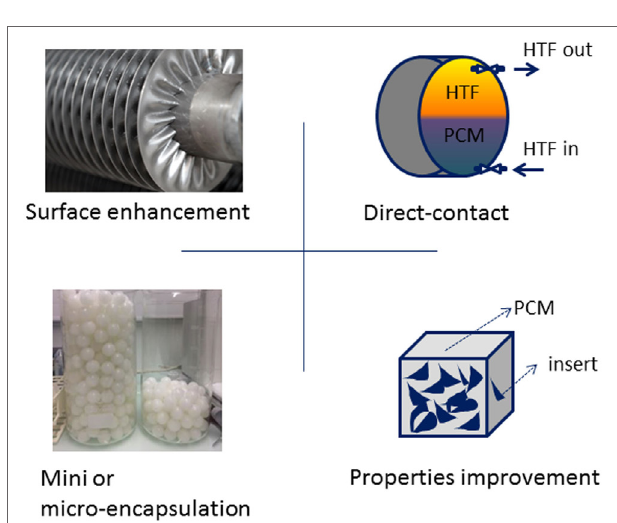
FigURe 7 | Heat transfer enhancements by geometry optimization and property improvement in phase change material (PCM) thermal storage.